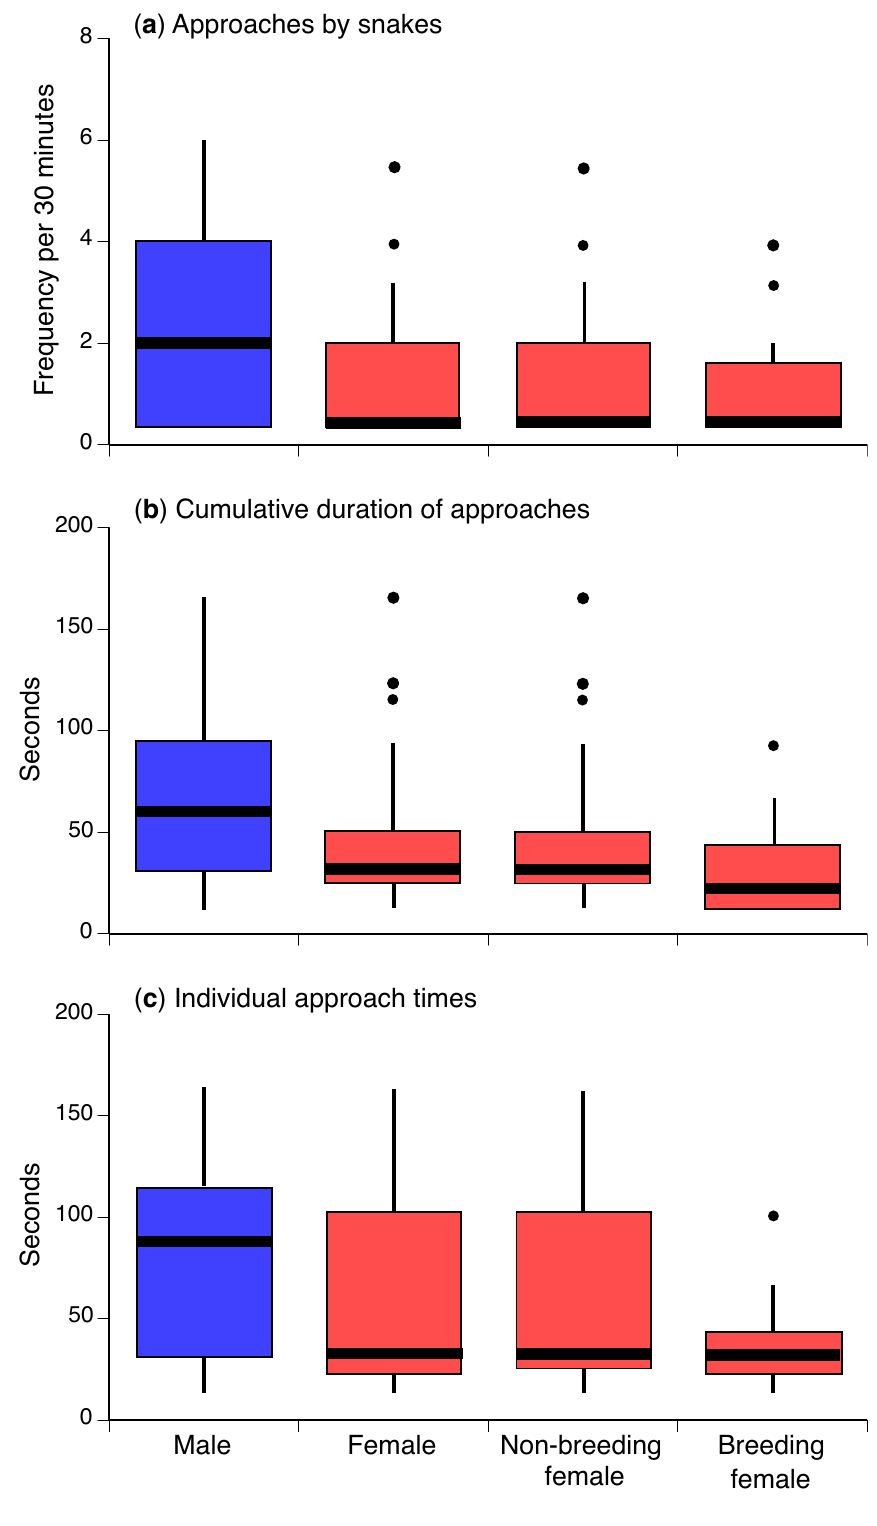
Figure 2. Approach frequency and duration by Olive sea snakes ( Aipysurus laevis ) during focal observation periods. The upper panel ( a ) shows the number of repeat approaches by the same individual within a 30-min focal observation session (data for snakes that did not approach are not included in the lower panels), and the lower panels show the duration of time for which snakes interacted with divers as a function of snake sex and season (breeding vs. non-breeding). Panel ( b ) provides data on cumulative time spent with the diver, whereas panel ( c ) shows mean times per approach. Boldface horizontal line shows median, box shows 25th to 75th percentile, lines are 95% confidence limits, and points show outliers. Focal animal observations: males N = 58, females N = 100, non-breeding season females N = 64, breeding season females N =